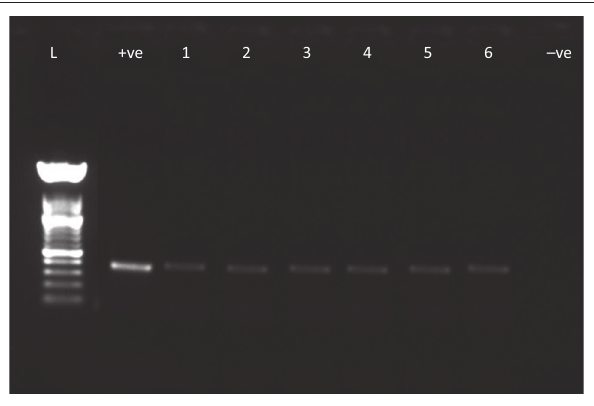
FIGURE 2: Gel image of polymerase chain reaction amplifications of the gltA gene.